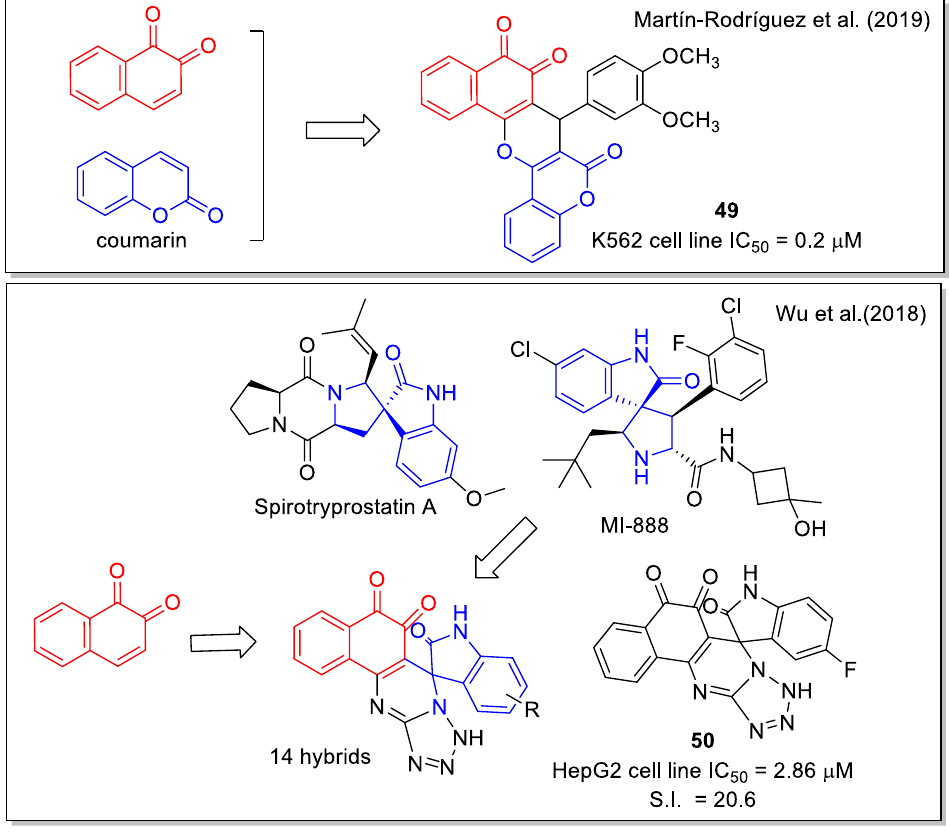
Figure 20. 1,2 Naphthoquinone hybrids with coumarin-dimethosxyaryl scaffolds as reported by Martin-Rodriguez et al. [59] and with spirooxindole-tetrazolopyrimidine by Wu et al. [60].